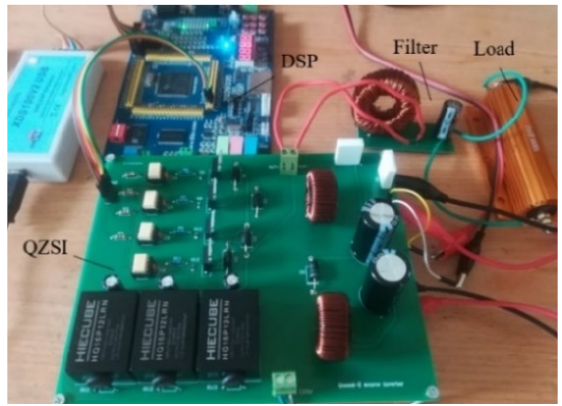
Figure 8. Experimental prototype in the laboratory.